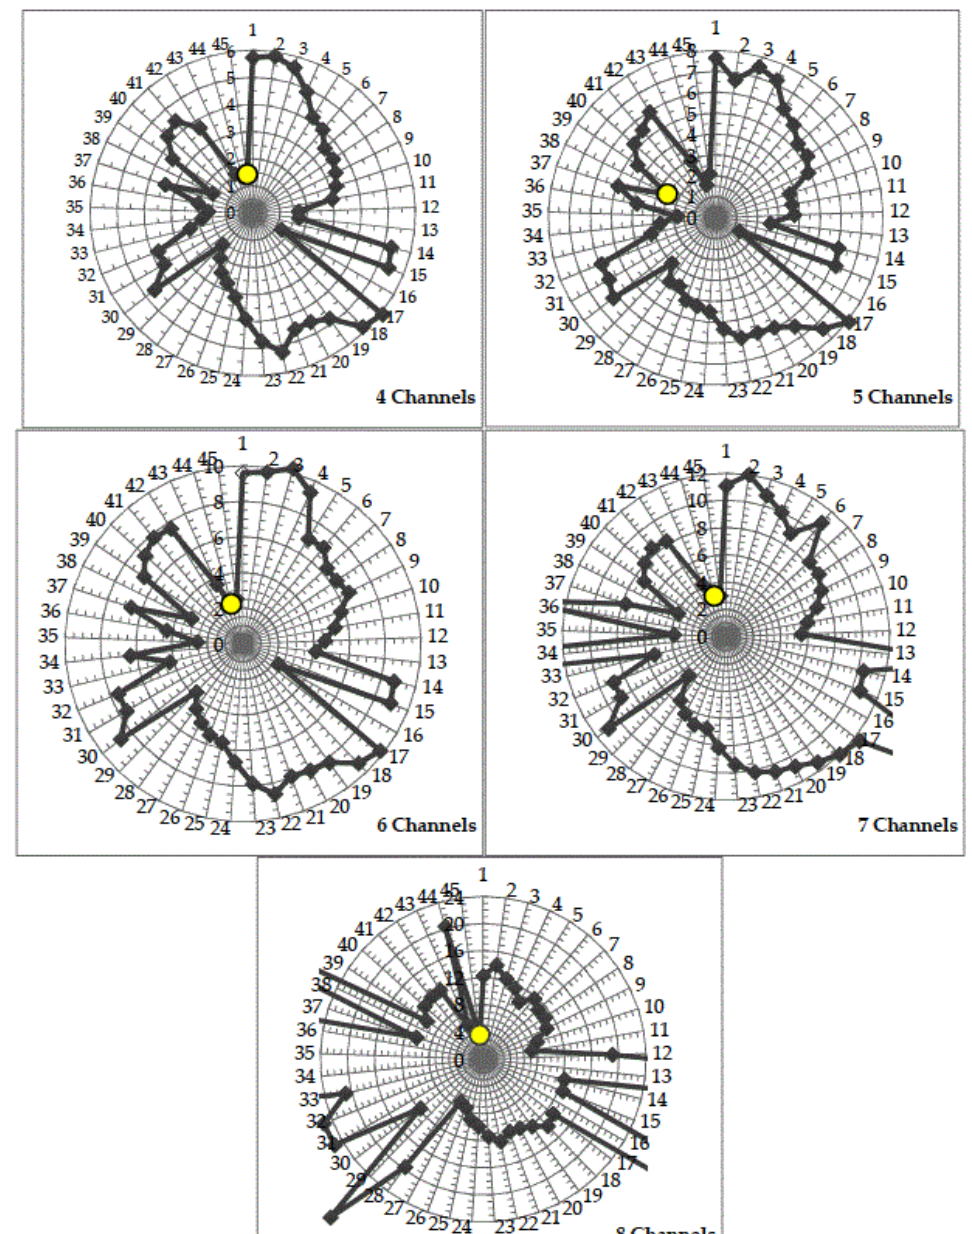
Figure 5. Radar charts of the condition numbers versus the corresponding filter sets in terms of several channel numbers. The radical coordinates denote condition numbers and the angular coordinates denote the No. of the filter sets, therefore the markers denote the position of condition number of the corresponding filter sets. In the radar charts at seven and eight channels, some of the condition numbers cannot be seen because they are too large to be displayed, however only the filter sets with the smaller ones deserve for